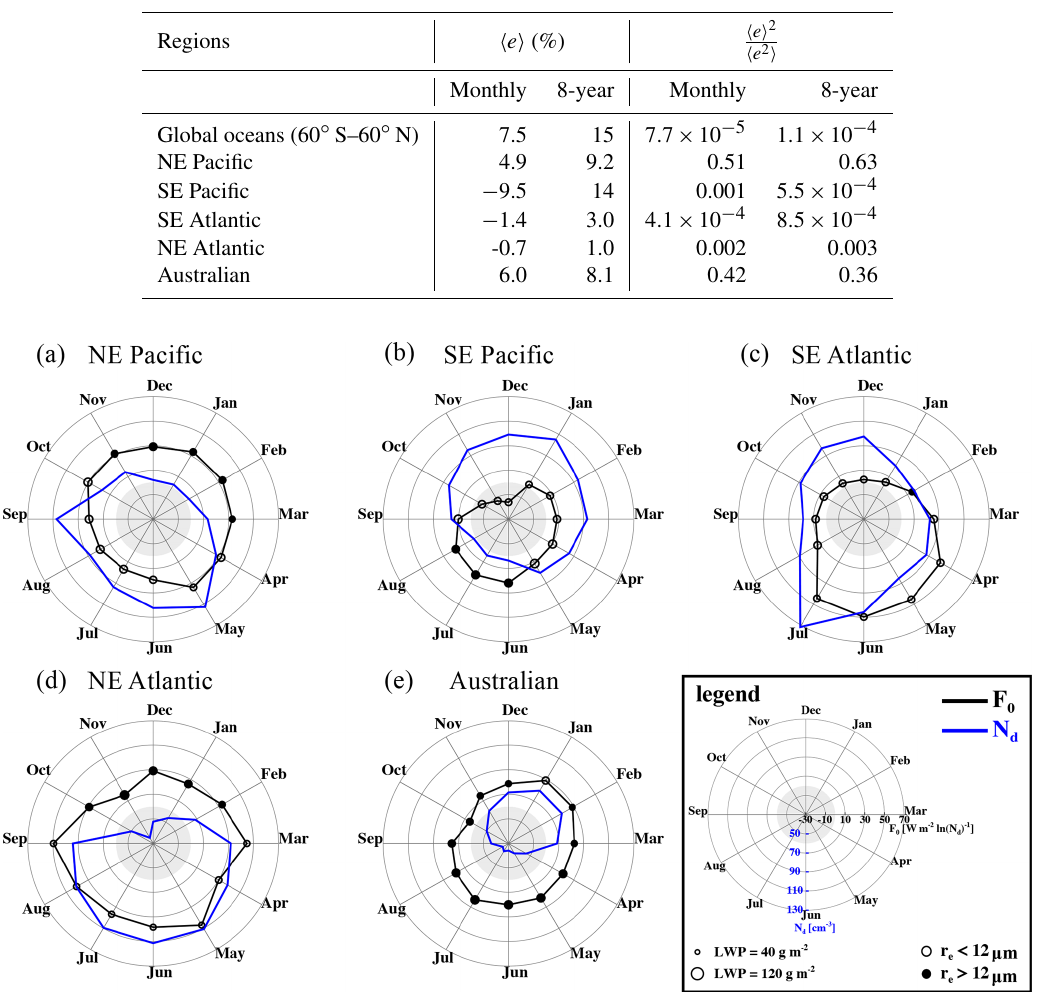
Table 1. Percentage bias ( e ) in time-mean F 0 due to temporal covariabilities among S 0 , f c , and SW dn . e is calculated as ( F ∗ is calculated using monthly mean and 8-year mean values. Mean of bias, (cid:104) e (cid:105) , and the ratio between the squared mean bias, (cid:104) e (cid:105) 2 , and the mean squared bias, (cid:104) e 2 (cid:105) , are shown for global oceans and the five stratocumulus regions. Angle brackets denote spatial averaging. Grid points with fewer than 30 samples and outside the 10th and 90th percentiles of e are excluded from the spatial averaging to remove highly uncertain bias calculations.